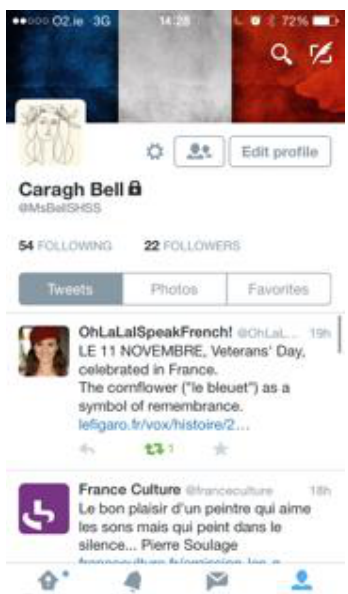
(Fig.1 Example of Twitter